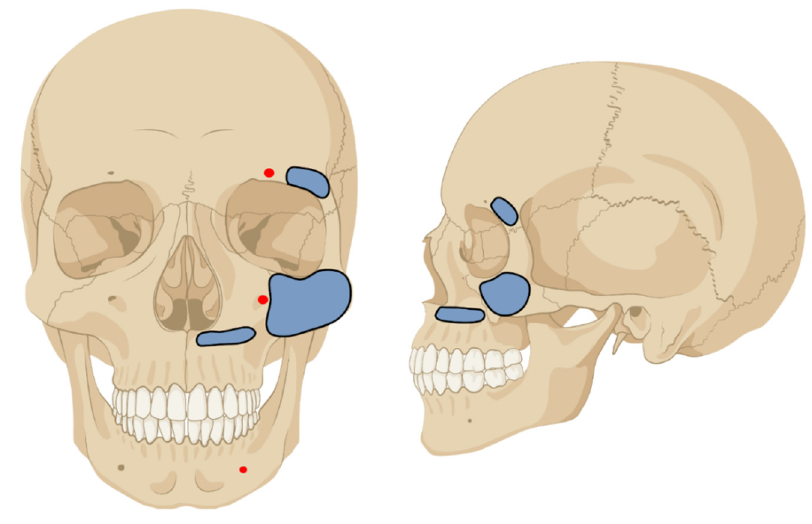
Figure 3. Nerve exit points and clinically tested safe zones for pin insertion for the External Face Fixator. Created with BioRender.com.